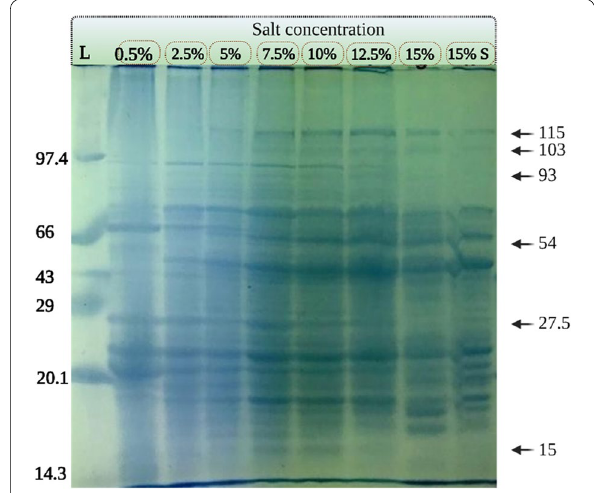
Fig. 3 Stained SDS-PAGE of whole cell proteins from MHN12 at varying salt concentrations. Lanes depicts the increasing salt concentration from 0.5 to 15%, 15% shock where L stands for Genei medium range protein ladder